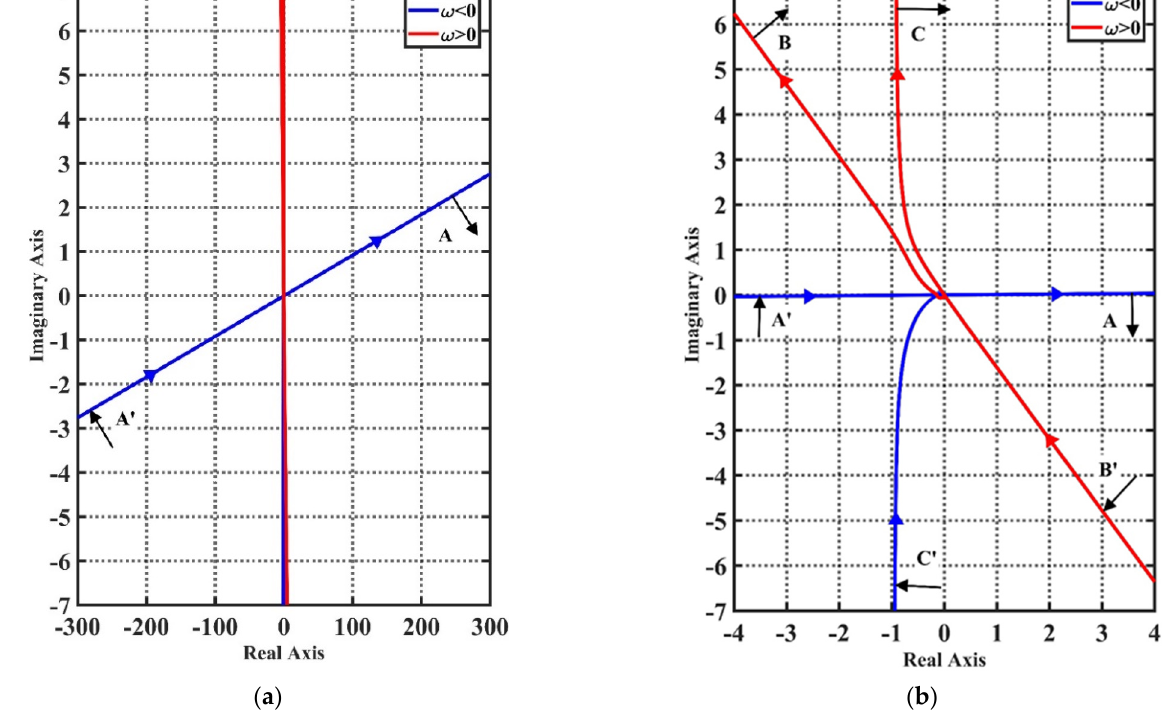
Figure 9. Inverse Nyquist diagram for Ω = 500 rad/s when Z s = − 2.2 mm. ( a ) Global; ( b ) Local. The inverse Nyquist curve turns 180 (cid:2925) clockwise from A to A (cid:4593) , B to B (cid:4593) and C to C (cid:4593) with infinite radii. Thus, it circles (−1,j0) zero times.